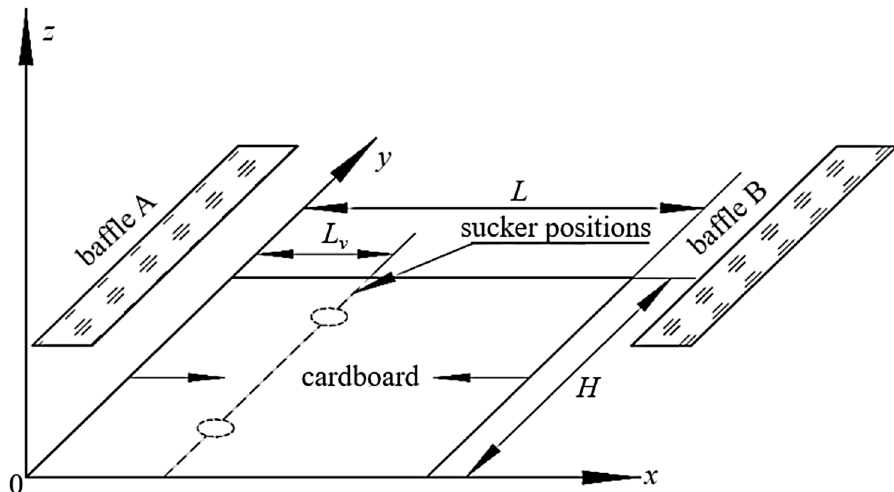
Fig. 4 Coordinate